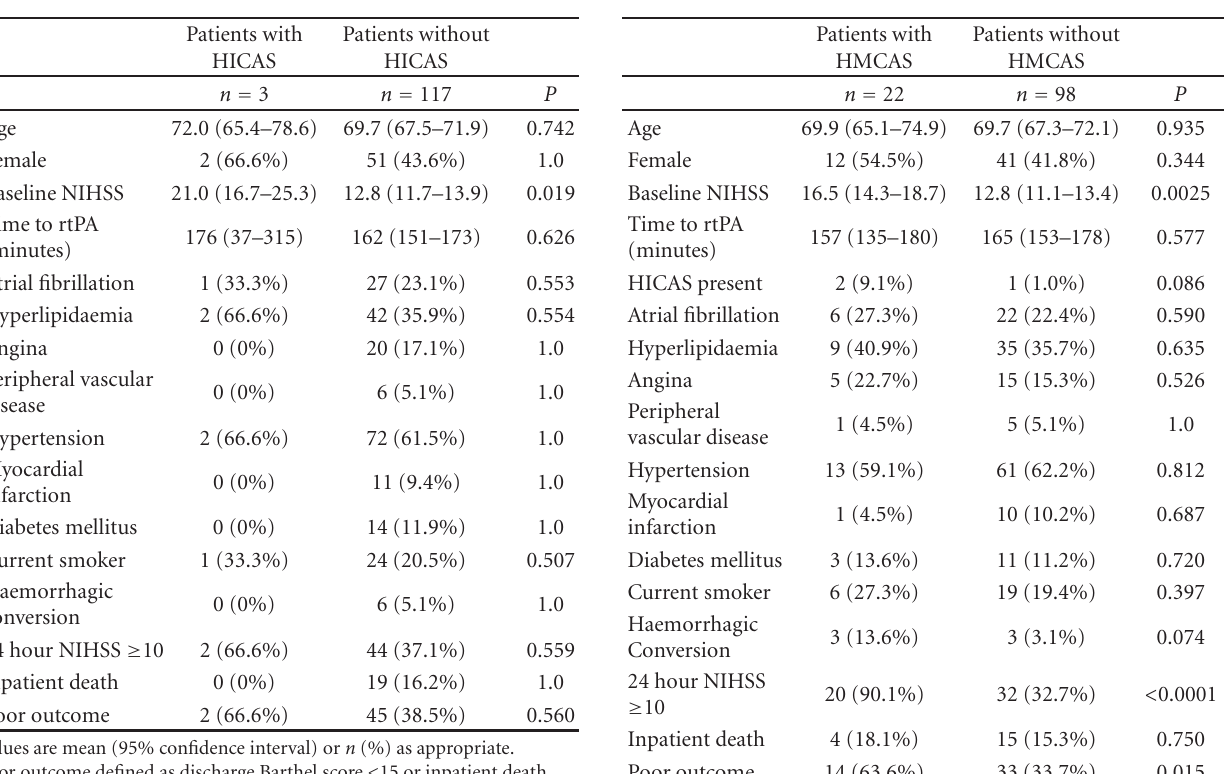
Table 1: Baseline characteristics and outcomes of patients with or without HICAS present.